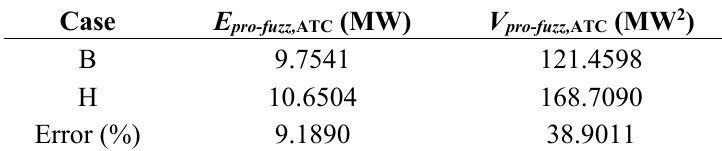
Table 7. The results of Case B and Case H.